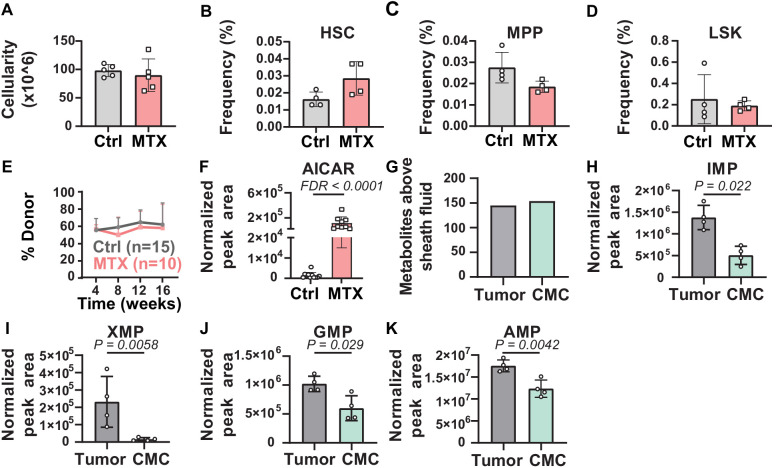
Metabolic differences between methotrexate-treated and control hematopoietic stem cells (HSCs) or circulating melanoma cells and primary tumors.(A–D) Bone marrow cellularity (A) and the frequencies of CD150+CD48-Lin-Sca1+c-kit+ HSCs (B), CD150-CD48-Lin-Sca1+c-kit+multipotent progenitors (MPPs) (C), and Lin-Sca1+c-kit+ cells (D) in femurs and tibias from mice treated with methotrexate or vehicle control (n = 5 mice per treatment from two independent experiments). (E) Percentage of nucleated blood cells that were donor-derived after competitive transplantation of bone marrow cells from methotrexate-treated versus control mice into irradiated recipients (two independent experiments). (F) AICAR levels in HSC/MPPs from mice treated with methotrexate or vehicle (11 control samples and 9 MTX samples from four independent experiments). (G) Metabolites detected above background in primary tumor cells or circulating melanoma cells (n = 3 or four replicates per treatment in one experiment; fold change >2 and false discovery rate [FDR] < 0.05). (H–K) Levels of the purines inosine monophosphate (IMP) (H), xanthosine monophosphate (XMP) (I), guanosine monophosphate (GMP) (J), and adenosine monophosphate (AMP) (K) in primary tumor and circulating melanoma cells. Statistical significance was assessed by t-test (A), repeated measures two-way ANOVA (B–D), or mixed effects analysis (E) followed by Sidak’s multiple comparisons adjustment. All tests were two-sided. Data represent mean ± SD. The flow cytometry gates used to isolate each cell population are shown in Figure 3—figure supplement 1. All of the metabolites that differed between circulating melanoma cells and subcutaneous tumor cells are listed in Figure 3—source data 2, Supplementary table 1.
Figure 3—source data 1.All source data for Figure 3.

Figure 3—source data 2.Supplementary table 1.Metabolites that differed between circulating melanoma cells and melanoma cells from primary subcutaneous tumors in xenografted mice (fold change >2 and p<0.05).